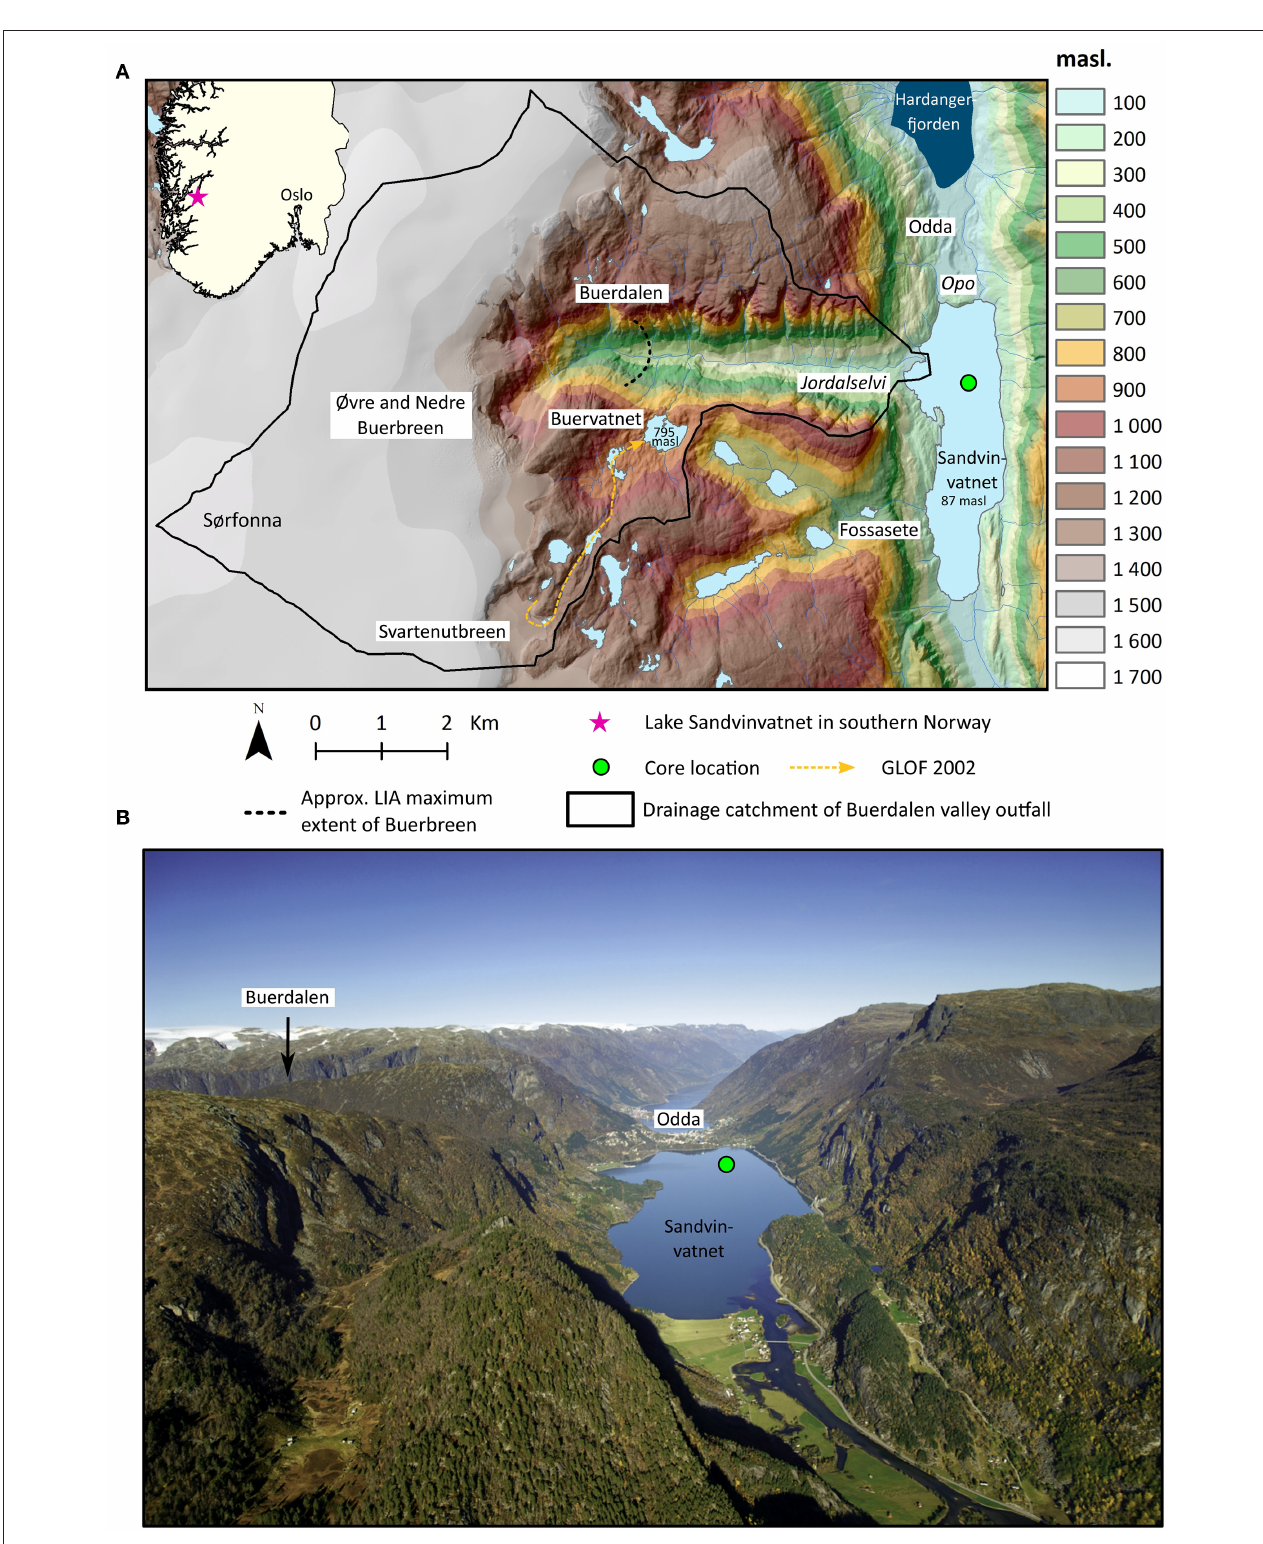
FIGURE 1 | (A) Study site with Lake Sandvinvatnet (to the east) and the Buerdalen valley, Lake Buervatnet, and the Sørfonna icecap (Folgefonna) to the west (background image from Kartverket/norgeskart.no, 2020). The LIA maximum extent is marked for Øvre and Nedre Buerbreen (black dashed line; Bakke et al.,